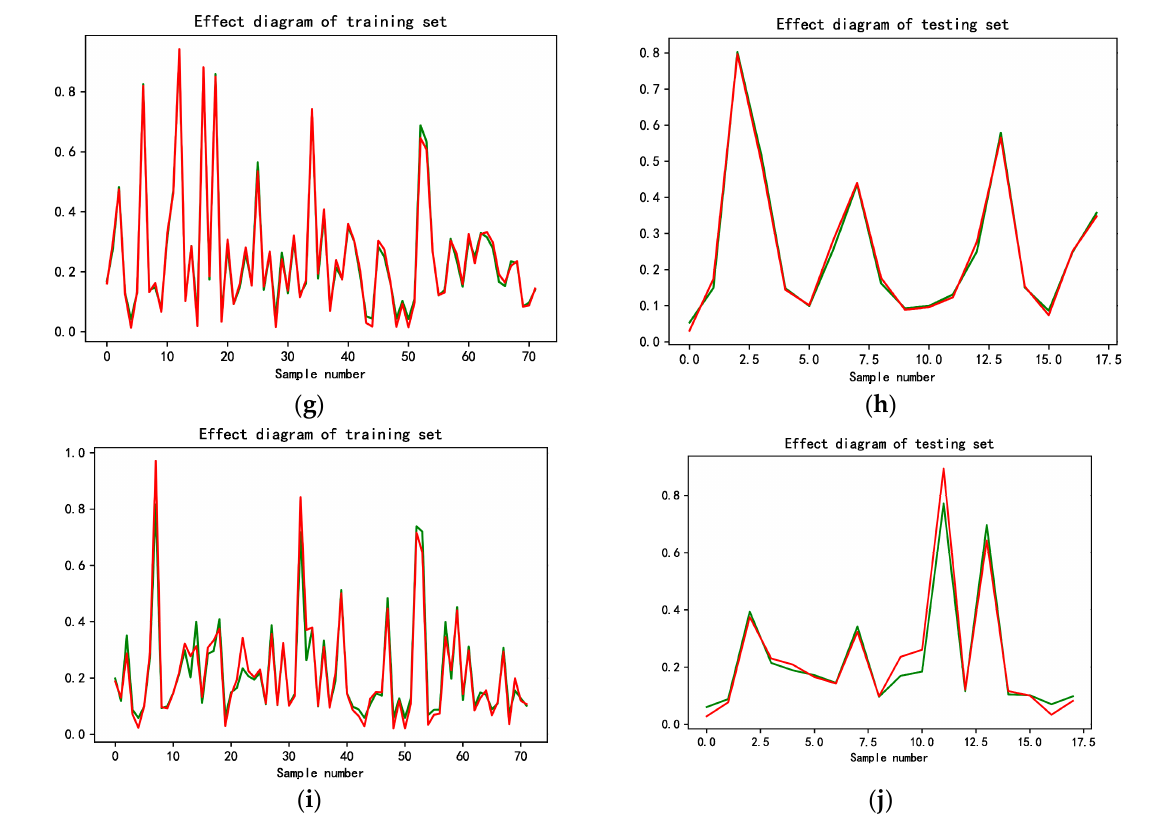
Figure 6. ( a ) Fitting effect diagram of labor force training set; ( b ) fitting effect diagram of labor force testing set; ( c ) fitting effect diagram of capital stock training set; ( d ) fitting effect diagram of capital stock testing set; ( e ) fitting effect diagram of total energy consumption training set; ( f ) fitting effect diagram of total energy consumption testing set; ( g ) fitting effect diagram of gross regional product training set; ( h ) fitting effect diagram of gross regional product testing set; ( i ) fitting effect diagram of carbon dioxide emissions training set; ( j ) fitting effect diagram of carbon dioxide emissions testing set.